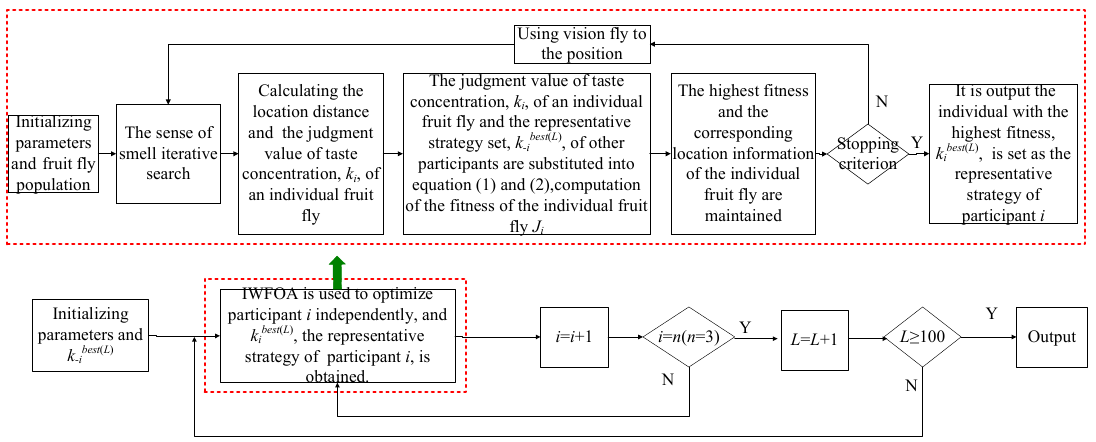
Figure 2. The flow chart of co-evolutionary algorithm based on the improved weighted fruit fly optimization algorithm (IWFOA).